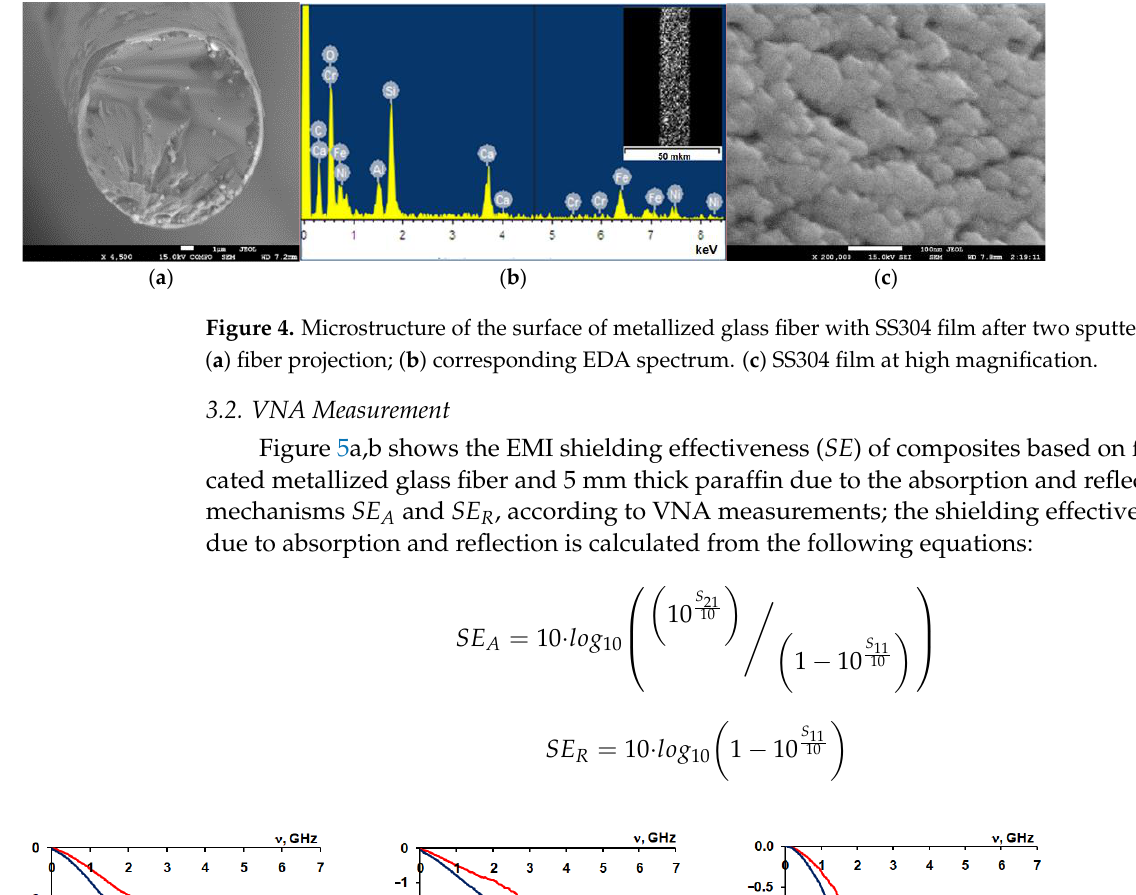
Table 2. Average characteristics of electromagnetic shielding efficiency ( SE ) and the value of dielec- tric loss tangent tg ɛ for samples of microwave shielding composites based on manufactured metal- lized glass fiber for 4G and 5G mobile communication bands.